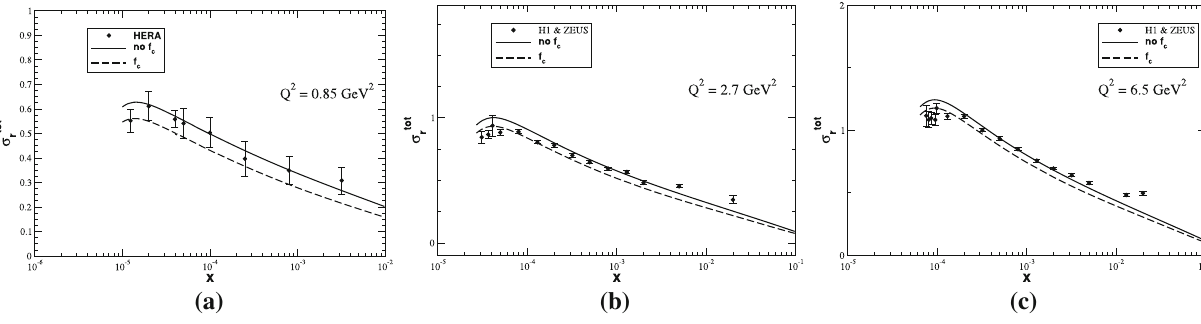
Fig. 6 Bjorken – x dependence of the reduced ep cross section for different values of the photon virtuality Q 2 . Data from Ref. [63]